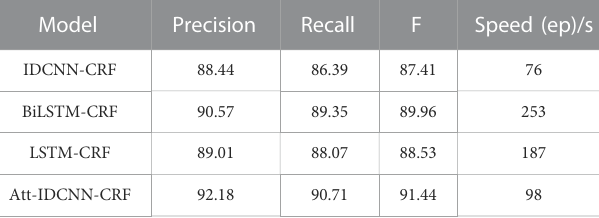
TABLE 3 Comparison of experimental results of recognition models. Model